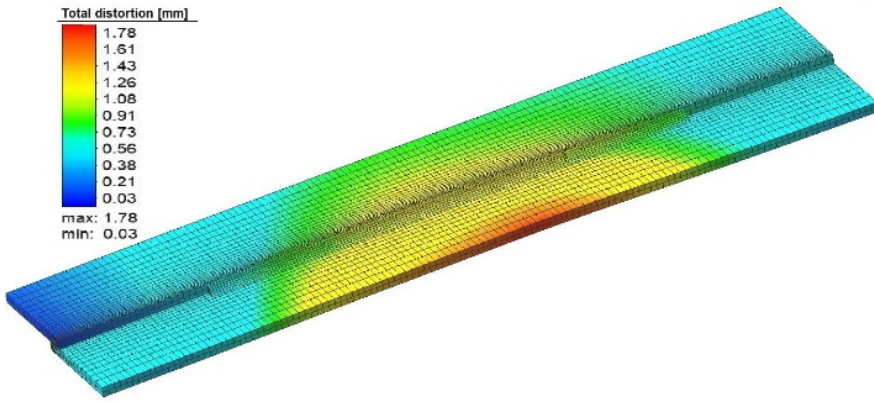
Figure 16. Total distortion produced in optimum weld sequence.